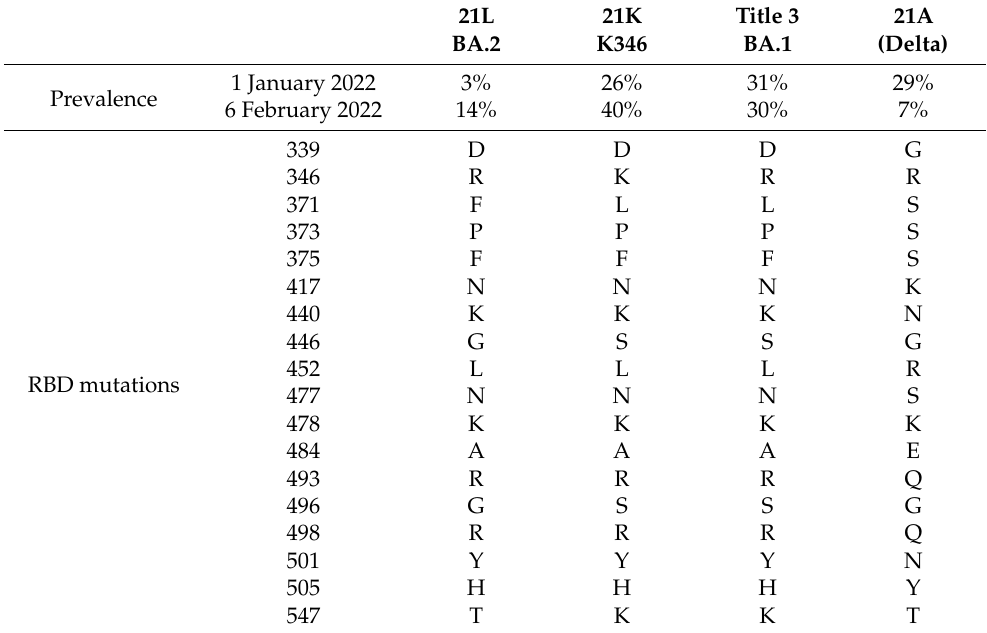
Table 1. The key RBD mutations in the SARS-CoV-2 Spike protein. The assignments to Delta (21A) and Omicron strains (21K and 21L) are